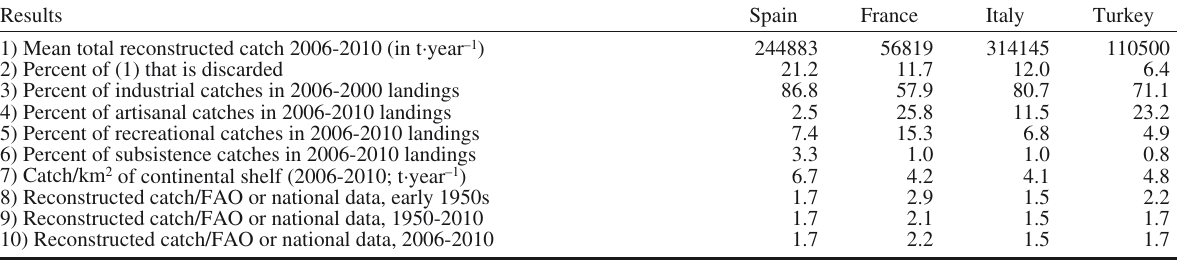
Table 1. – Summary statistics of key features influencing fisheries along the Mediterranean coast of the four countries represented here, from Results